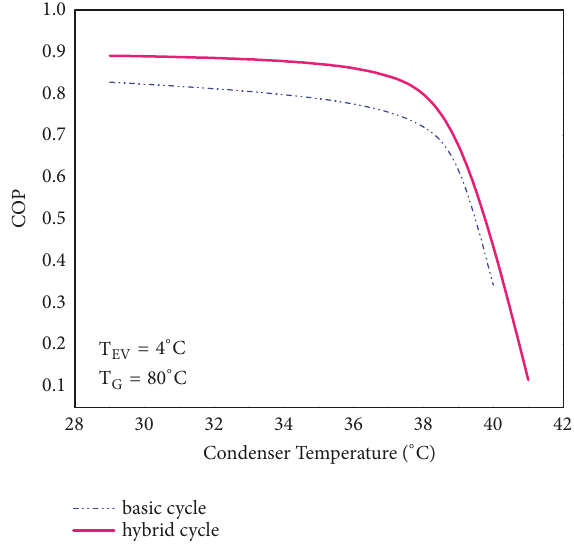
Figure 6: 𝐶𝑂𝑃 of hybrid and conventional cycle vs . machine generator temperature, 𝑇 𝐺 (𝑃 18 = 15 bar ; 𝑇 18 ≈ 200 ∘ C ) .